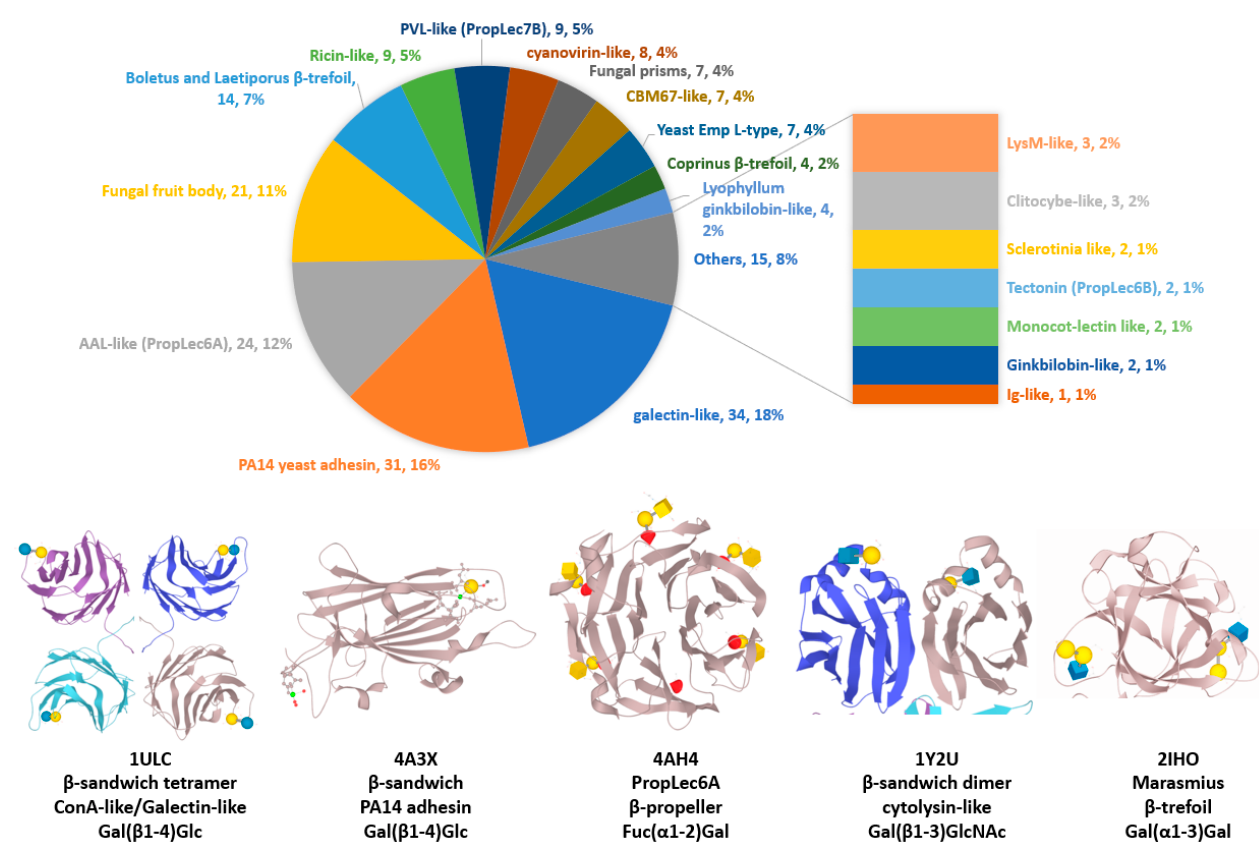
Figure 1. Distribution of fungal lectins 3D structures classes in UniLectin3D accessed on January 2021. Bottom: 3D view of most common folds for fungal lectins, using selected structures from the PDB (www.rcsb.org) [35] : 1ULC from Coprinopsis cinerea ; 4A3X from Candida glabrata; 4AH4 from Aspergillus fumigatus ; 2IHO from Marasmius oreades ; 1Y2U from Agaricus bisporus.